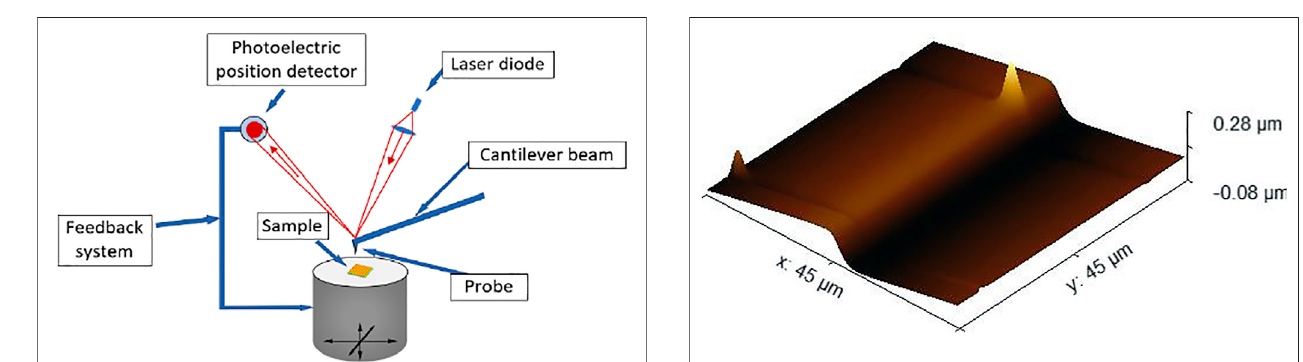
FIGURE 4 | Atomic force microscope original